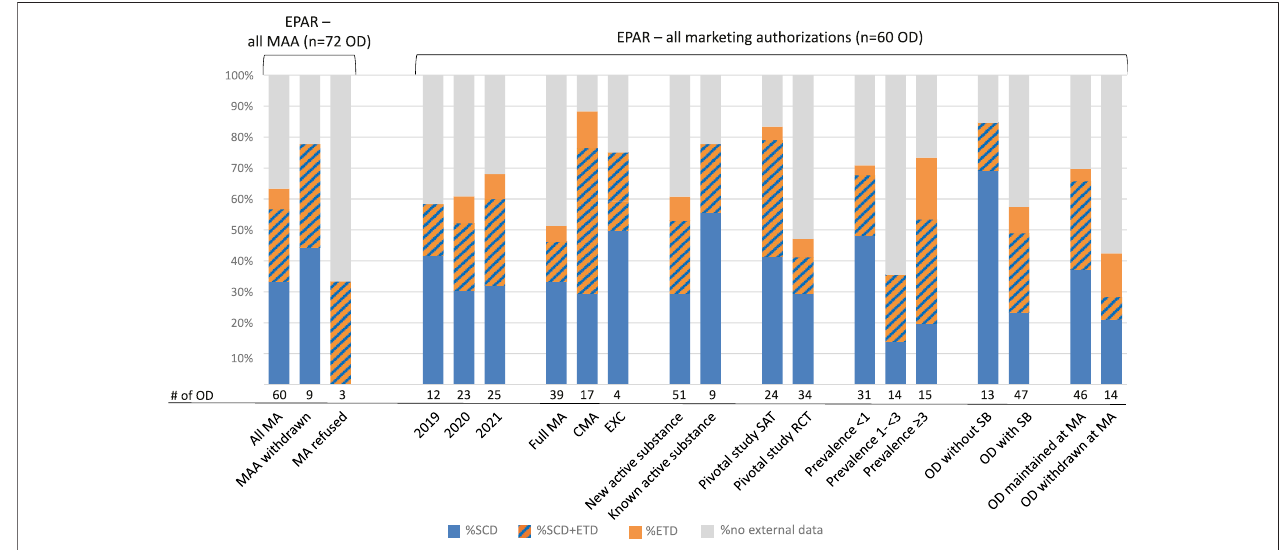
FIGURE 3 | Types of external data submitted in the pre-authorization period. N = 72 (all EPARs) or n = 60 ODs (only EPARs on successfully authorized products), respectively, were searched for reference to external data and analyzed for the type of data. The numbers of subgroups are stated below the columns. The subgroup “ SAT+RCT ” wasconsideredtoosmalltobeincludedinthe fi gure(n=2)butistabulatedin SupplementaryTableS1 .CMA:conditionalmarketingauthorization;EPAR: European public assessment report; ETD: external trial data; EXC: marketing authorization under exceptional circumstances; MA (A): marketing authorization (application); OD: orphan designation; RCT: randomized controlled trial; SAT: single-arm trial; SB: signi fi cant bene fi t; SCD: structured clinical data.